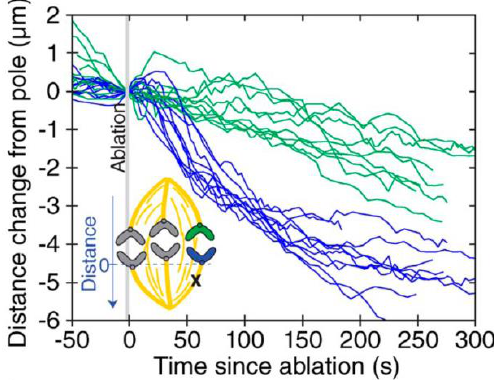
Figure 9. Change in distance from chromatids to poles before and after ablation of their kinetochore- associated microtubule fibers (k-fibers) during anaphase. Chromatids attached to ablated k-fibers ( blue traces ) are pulled toward poles faster than anaphase movement of their unmanipulated sisters ( green traces ) before resuming normal anaphase movement (at ~70 s). This graph is reprinted from [60], and is displayed under the terms of a Creative Commons License (Attribution-Noncommerical-Share Alike 3.0 Unported license, as described at http://creativecommons.org/licenses/by-nc-sa/3.0/).